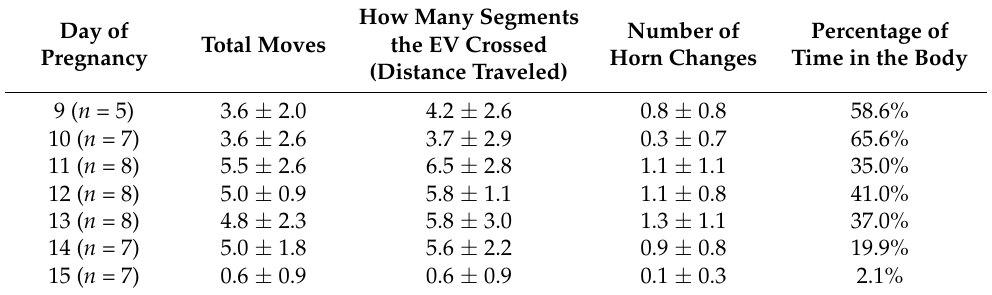
Table 2. Mean ( ± SD) mobility characteristics of the embryonic vesicle (EV) during a 2-h mobility trial. How Many Segments Number of Percentage Day of Total Moves the EV Crossed Horn Changes Pregnancy (Distance Traveled)